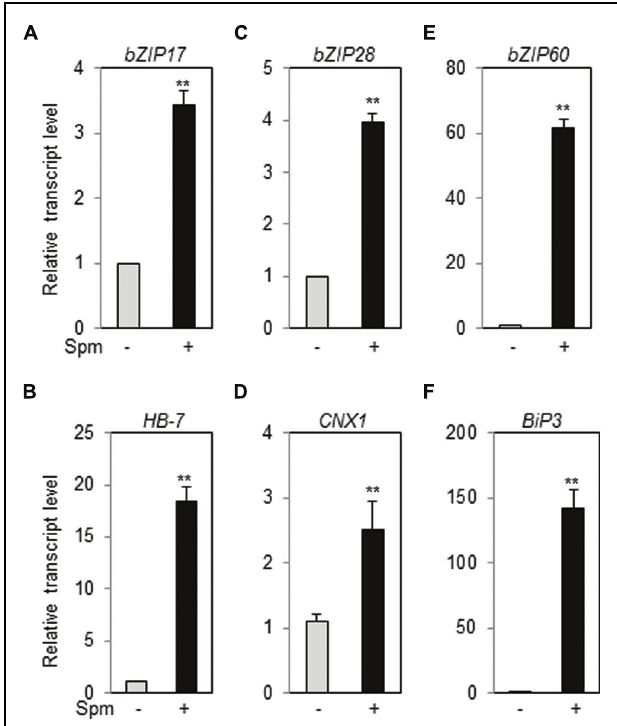
FIGURE 1 | Exogenous Spm induces the expression of bZIP17 , bZIP28, and bZIP60 and their target genes. qRT-PCR was performed using the cDNAs prepared from control- and Spm-treated Arabidopsis seedlings. (A) bZIP17 ; (B) HB-7 ; (C) bZIP28 ; (D) CNX1 ; (E) bZIP60 ; (F) Bip3 . The transcript level in control Arabidopsis plant was set as 1 and relatively displayed. Values are mean ( ± SD) from three independent experiments. Asterisks indicate significant difference ( ∗∗ P <